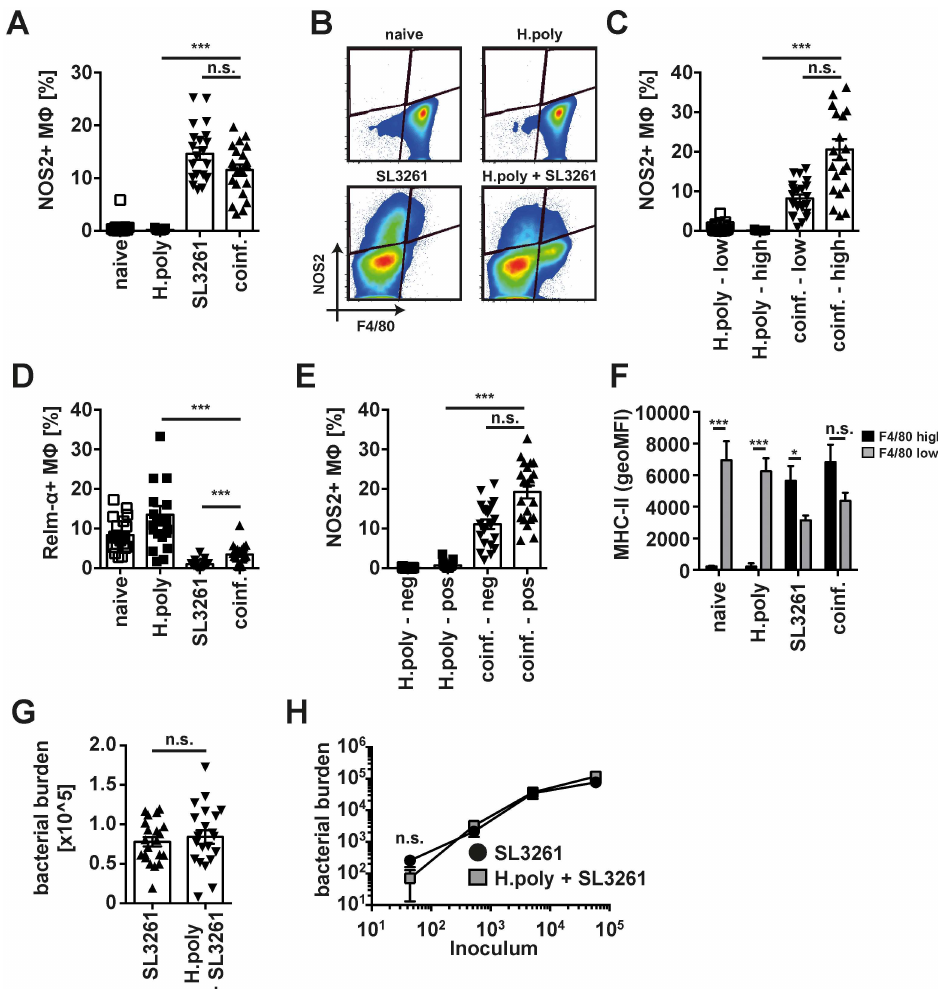
Fig 3. Helminth-expanded M Φ upregulate NOS2 and MHC-II expression following bacterial infection. (A) IntracellularNOS2 stainingin peritonealM Φ from SL3261(SL3261), H . polygyrus (H.poly) co-infected (coinf.) or naive mice. (B) Representative dot plots depictingNOS2 vs. F4/80 expressionin peritonealM Φ isolatedin A. (C) Quantitative analysisof NOS2 expressionin F4/80 high (high) or F4/80 low (low) M Φ isolated in A (D) Intracellular Relm- α staining in M Φ isolated in A. (E) Quantitative analysisof NOS2 expressionin Relm- α positive (pos) or negative(neg) M Φ isolatedin A (F) MHC-II expression(geometric mean fluorescence intensity) on F4/80 high and F4/80 low M Φ isolatedin A. (G) Splenic bacterial burdenin single SL3261(SL3261) or consecutively H . polygyrus . / SL3261co-infected(H.poly + SL3261)mice. Data pooledfrom 4 separate experiments with 5–6 animalsper group per experiment. Datapointsdepict individualanimalsand bars indicatemean and SEM. (H) As in G utilizingindicatedinfectiondoses of SL3261. One representative experiment of 2 with 5 animalsper group shown. * : p < 0.05; ** : p < 0.01, *** ; p < 0.001;n.s.: not